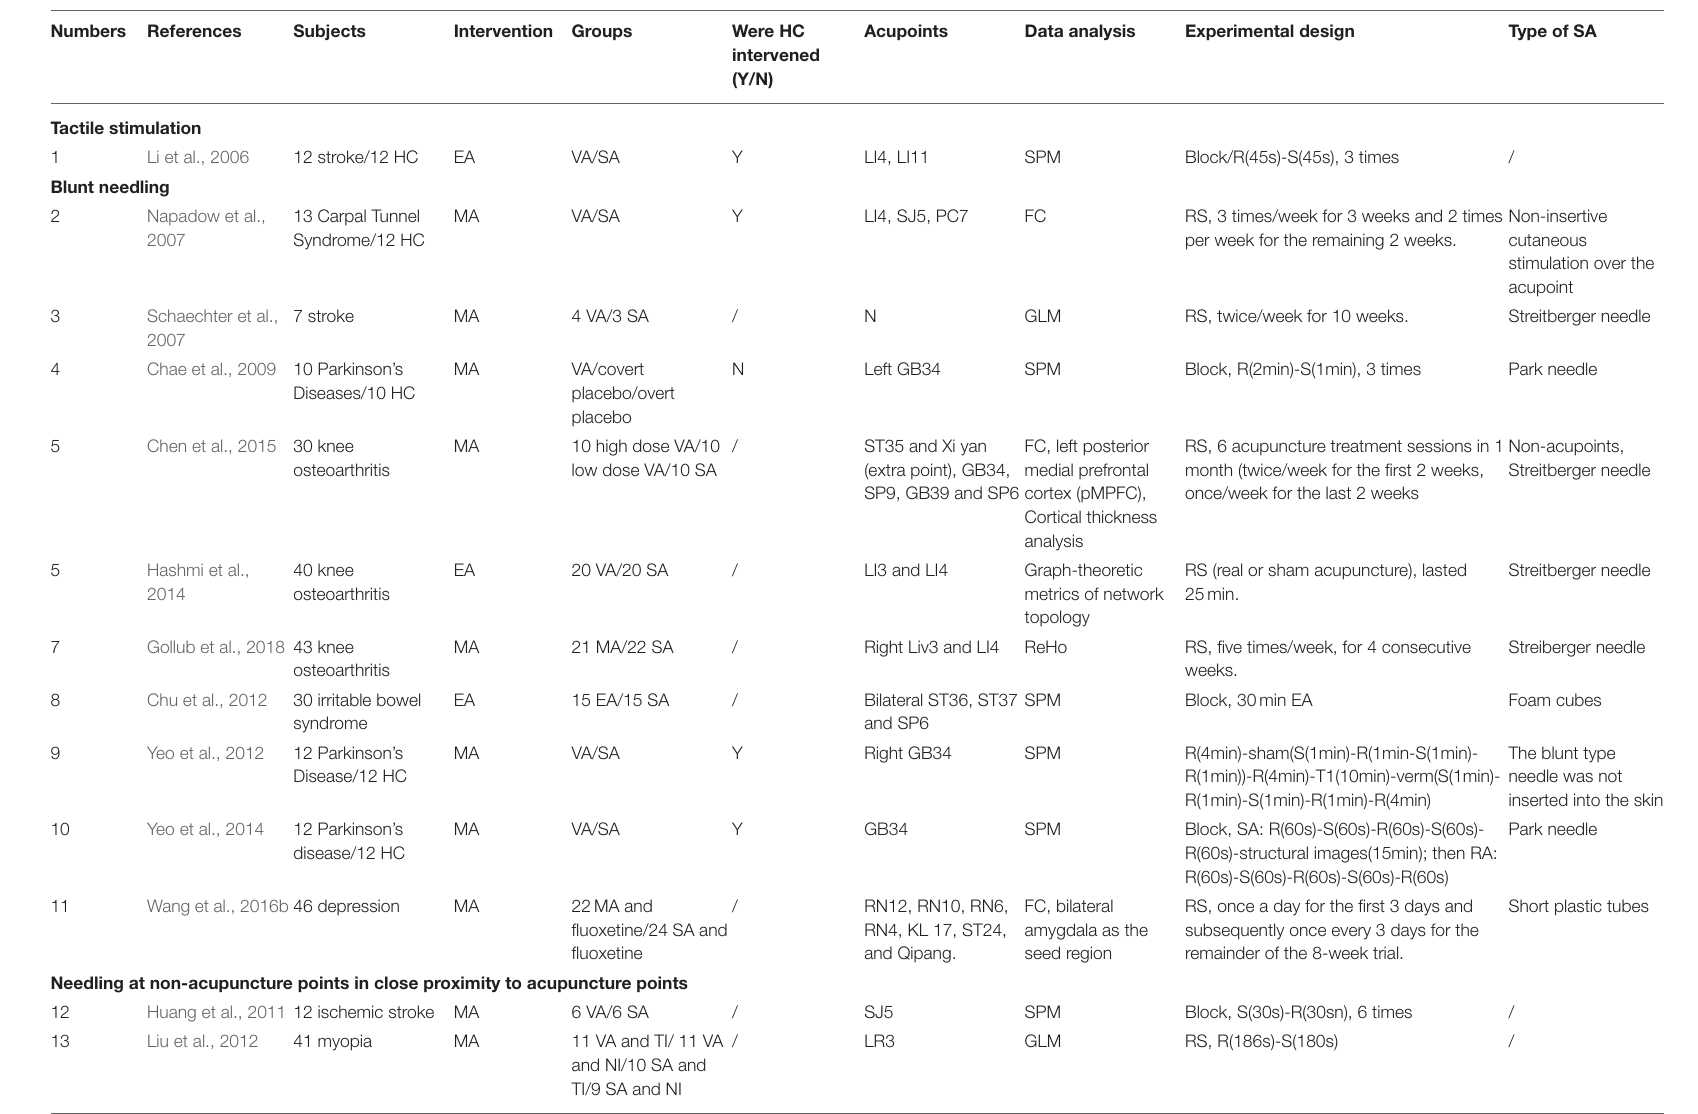
TABLE 1 | Characteristics of studies about VA and